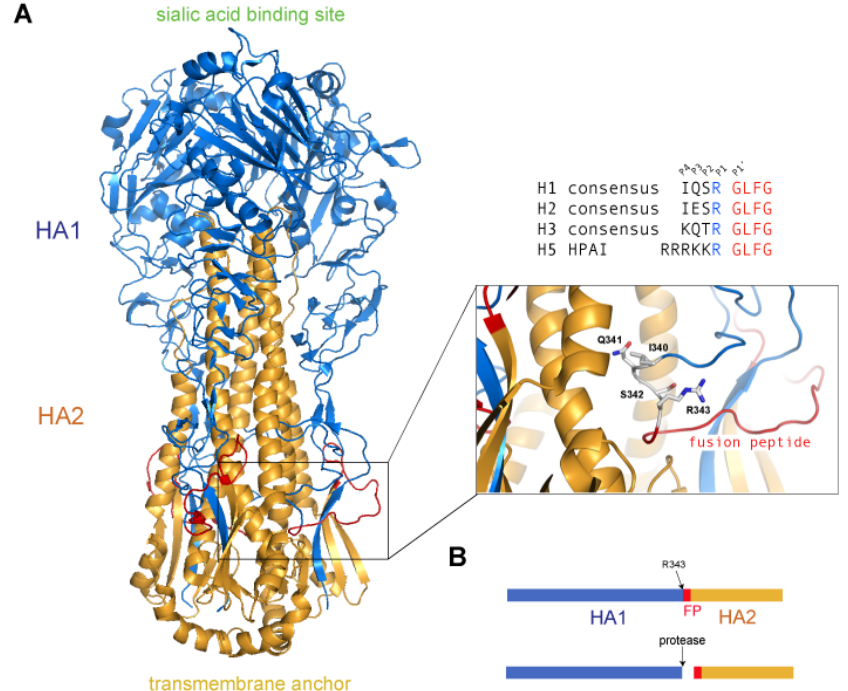
Figure 2. Cleavage of the HA precursor (HA ( A ) Structure of the non-cleaved, trimeric A/South Carolina/1/18 HA (H1N1) (PDB